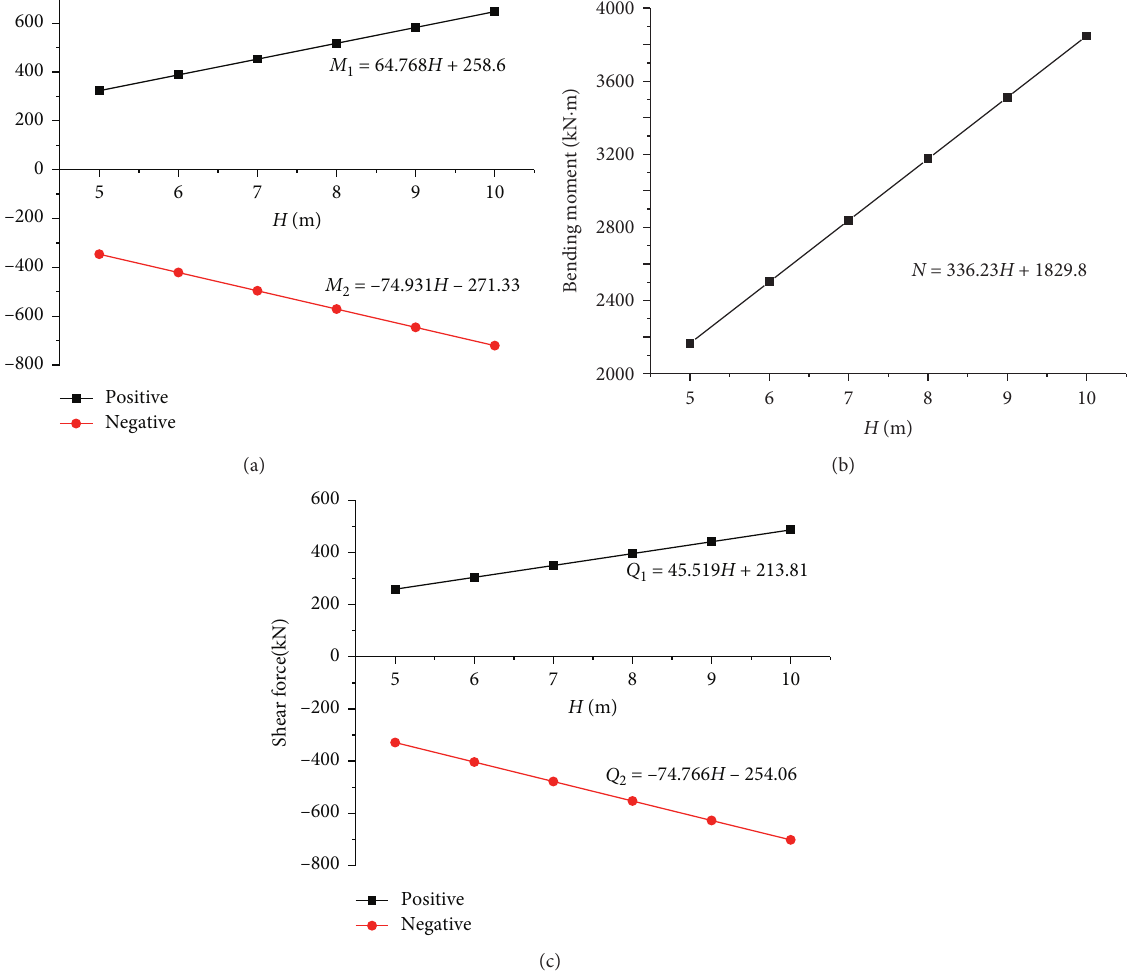
Figure 14: Variations of largest magnitudes of internal forces with ( H ): (a) bending moment; (b) axial force; (c) shear force.